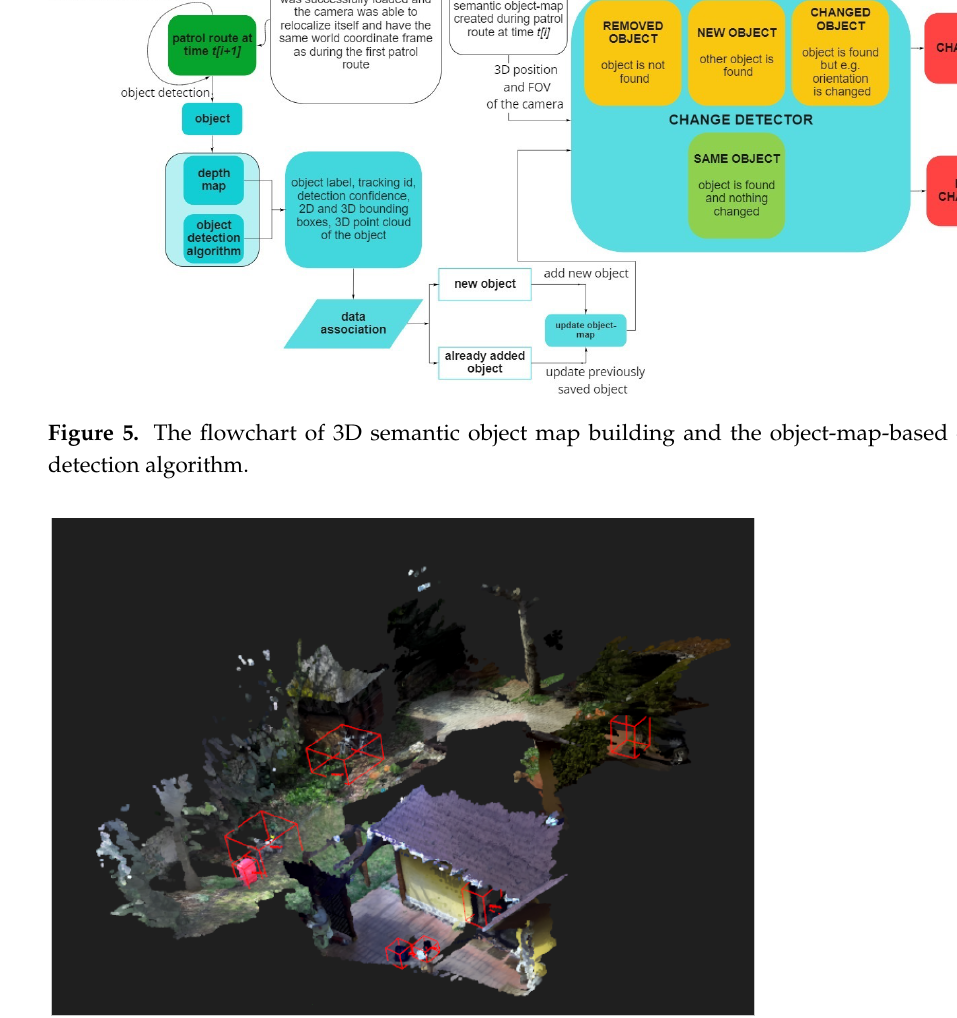
Figure 6. Result of the semantic object map after postprocessing with the 3D bounding boxes of objects